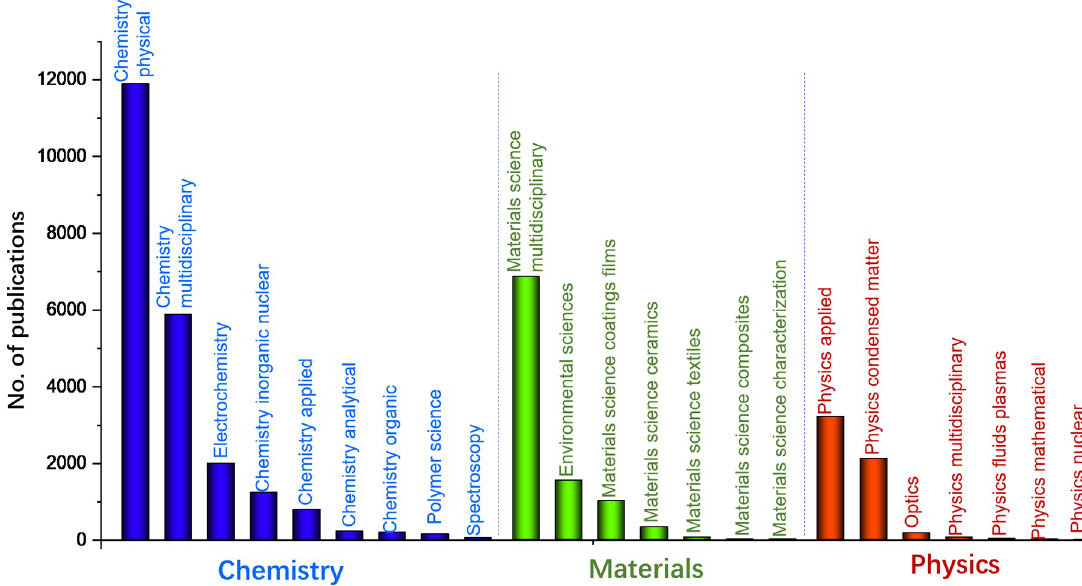
Fig 2. The number of papers published of the disciplines of Chemistry, Materials and Physics (Top 3 of first level discipline).